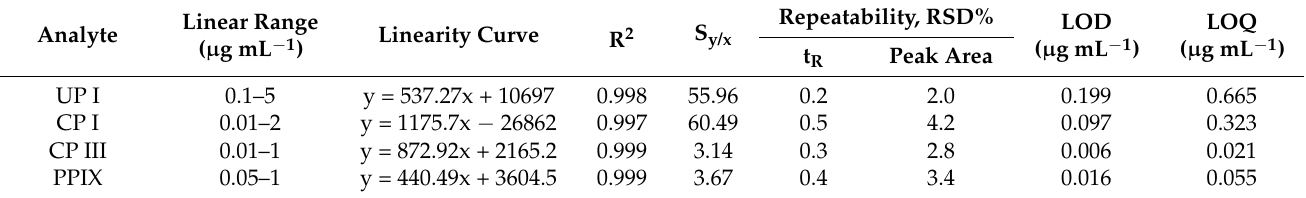
Table 3. Linearity, calibration data and figures calculated for the chromatographic method pro- posed for the analysis of natural porphyrins in hairs.